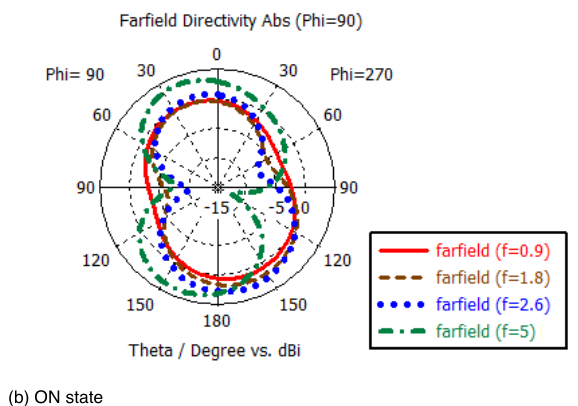
FIGURE 5. Radiation pattern of the proposed single antenna